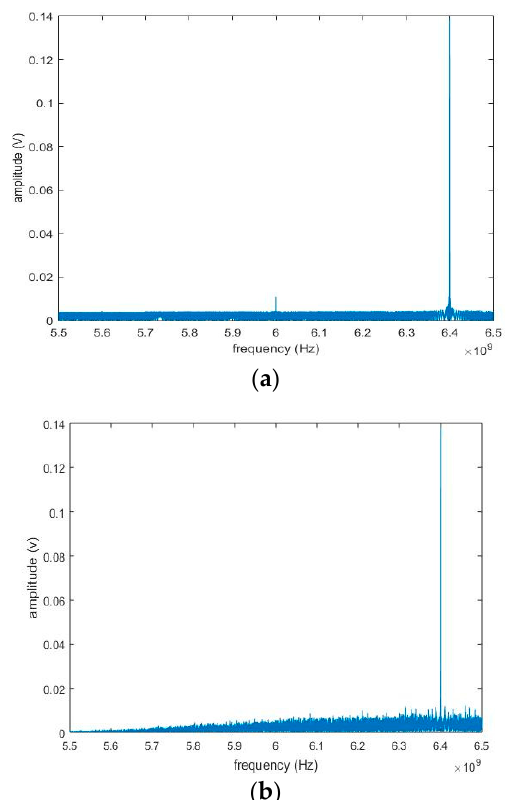
Figure 3. The output pulse of the single input frequency of 6.4 GHz based on CTS system. Frequency resolution of the output pulses using the classical time-domain pulse compression method ( a ) and the LPSA algorithm ( b ).